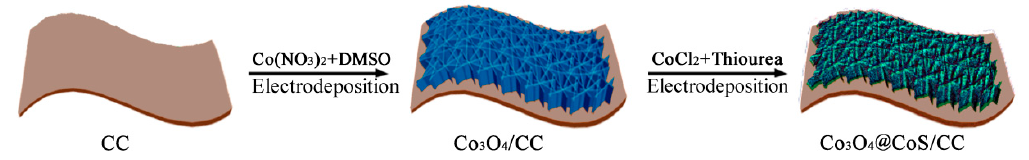
Figure 1. Schematic illustration of the two-step synthesis of Co 3 O 4 @CoS core-shell nanosheet arrays on carbon cloth (CC).